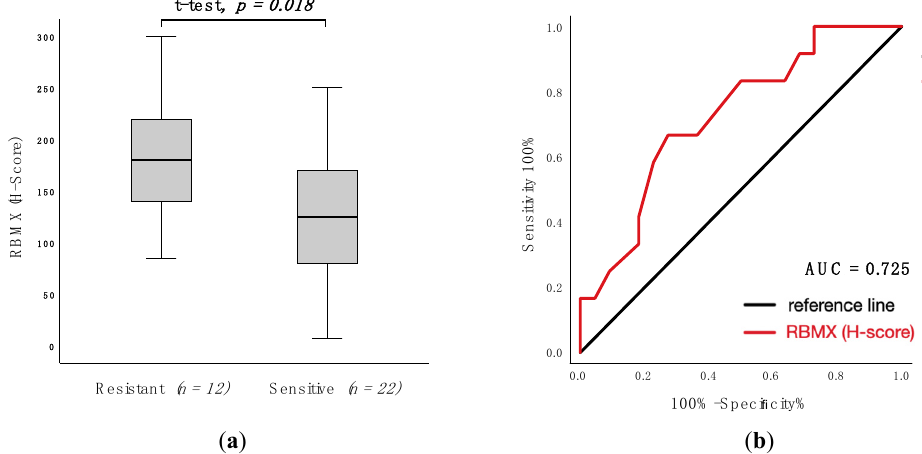
Figure 3. RBMX expression according to response following anthracycline-containing first-line treatment in T-NHL. ( a ): Corresponding histogram of RBMX expression (H-score) in resistant and Scheme 0. ( b ): ROC analysis of RBMX expression (H-score) to discriminate between resistant and sensitive groups. AUC (area under the curve) = 0.725 (95% confidence interval: 0.550–0.901; p = 0.012). Abbreviations: CHOP: cyclophosphamide, doxorubicin, vincristine, and prednisone content chemotherapy; CHOEP: cyclophosphamide, doxorubicin, vincristine, etoposide, and prednisone content